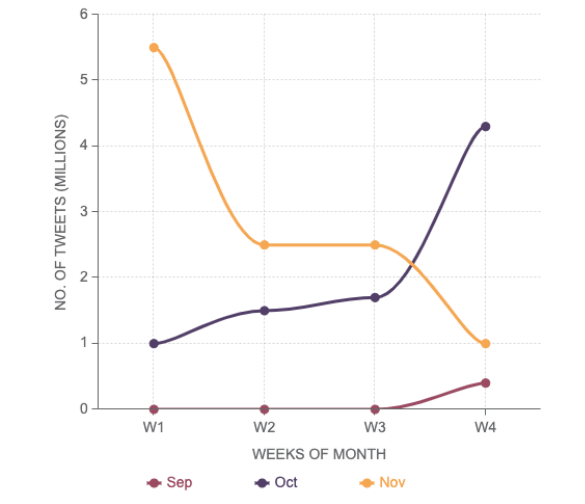
Figure 5. Collection time period of tweets.